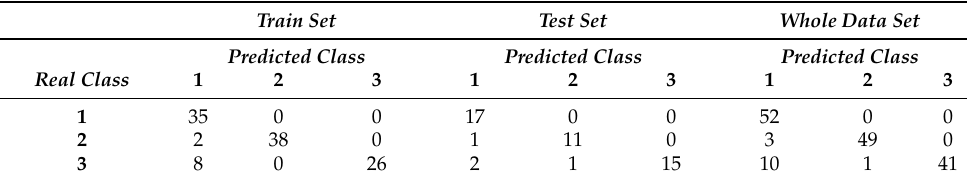
Table 7. Confusion Matrices of the Best Rule Set (3-Class